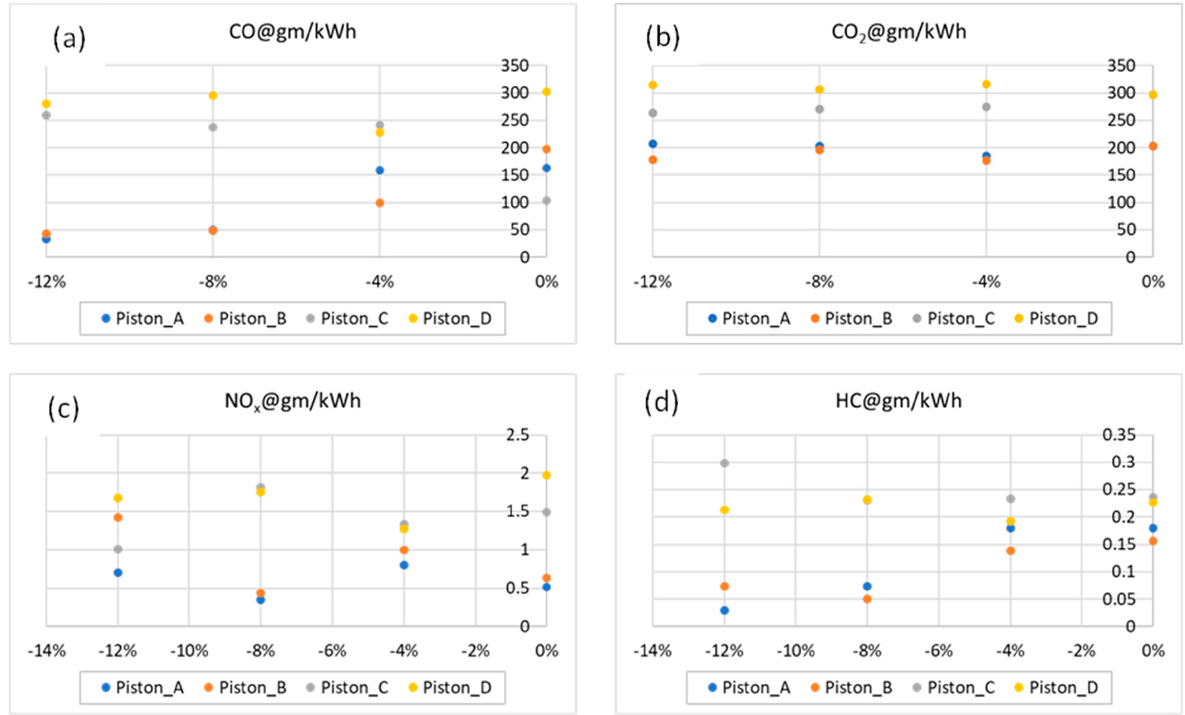
Figure 6. Fuel carbon redundancy effect on emission formation at 1500 rpm, BMEP@5.95 bar, CT@0.8 mm, and variable piston design exchange: ( a ) CO@gm/kWh; ( b ) CO 2 @gm/kWh; ( c ) NO x